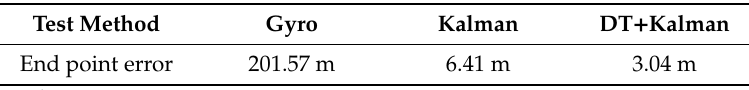
Table 3. Comparison of the end point positioning error in outdoor track 1 . Figure 12. Trajectory test of the three different algorithms for outdoor pedestrian inertial navigation. The walking time is 598.6 s outdoors.